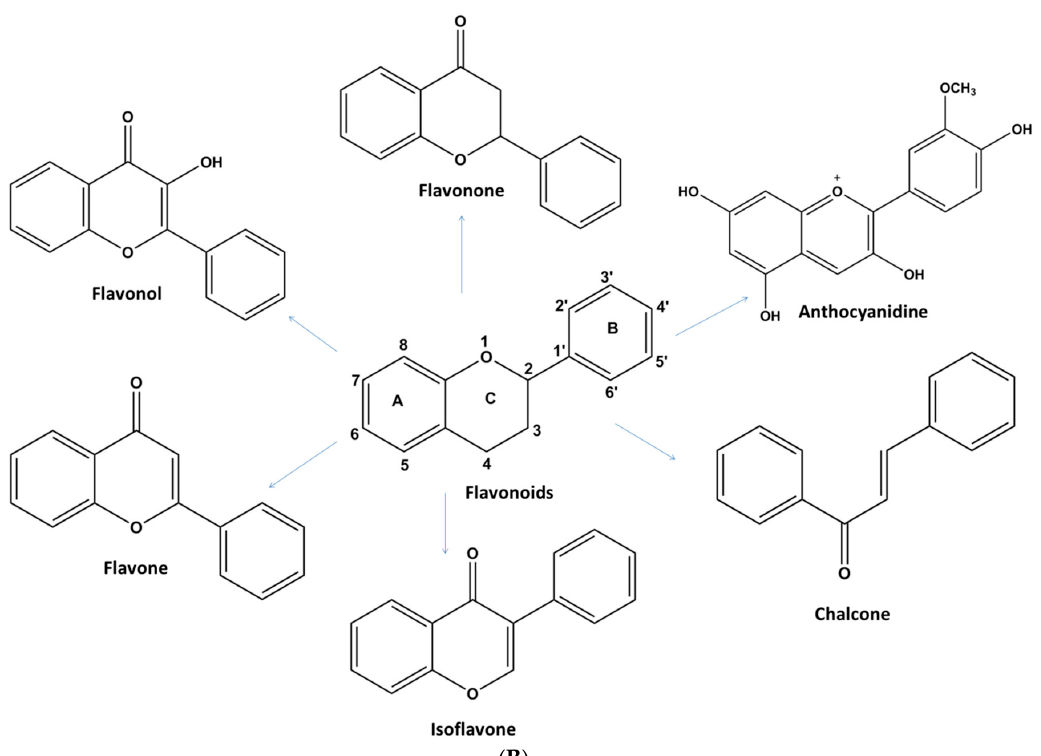
Figure 2. ( A ) Flavonoids and their types ( B ) Basic structure of common flavonoids. Flavonols